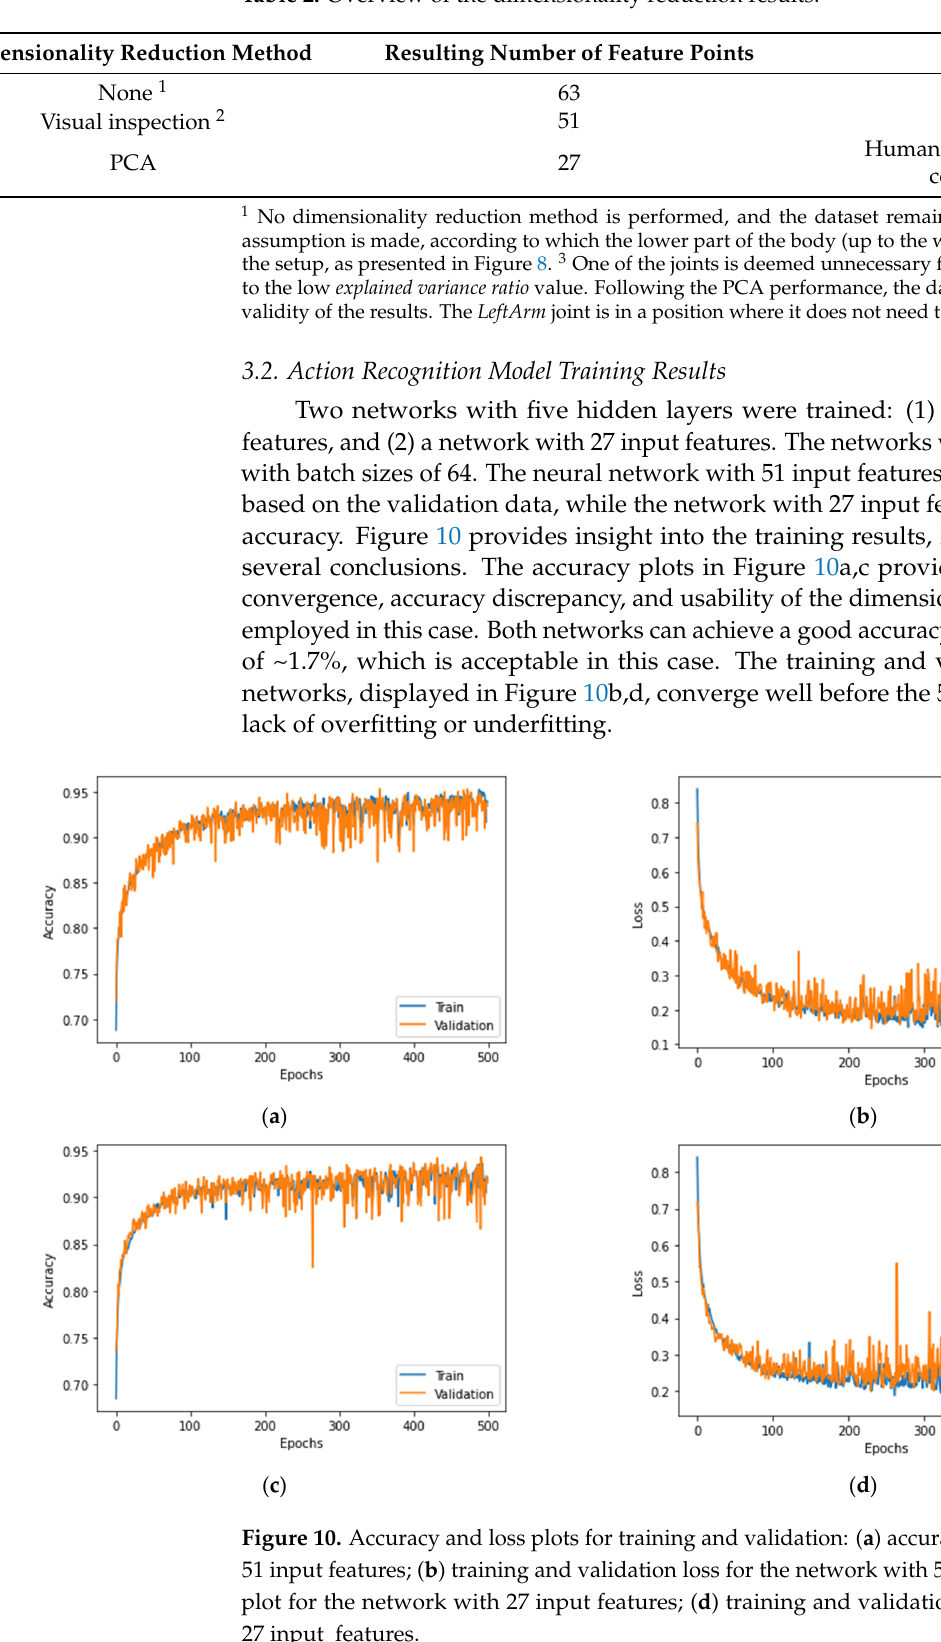
Table 3. Precision, recall, and F1-score for the trained models. Metric